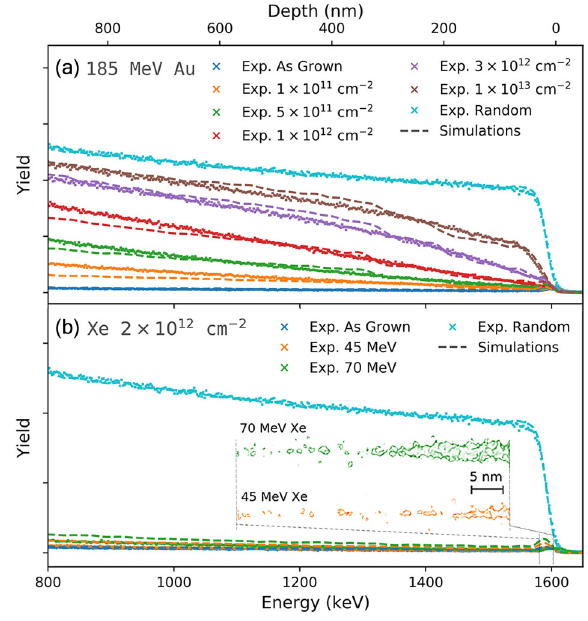
Fig. 6 Rutherford backscattering spectrometry/channelling data of irradiated samples. Aligned and random RBS/C spectra of the samples (symbols) and corresponding simulations (lines) for a 185 MeV Au, b 70 and 45 MeV Xe irradiations. The aligned spectra are obtained by aligning the probe beam along the [001] axis of the samples. The random spectra are collected from the as-grown sample by tilting it by 5 o with respect to the probe beam direction and rotating the sample during the measurement. The inset shows the dislocation extraction algorithm output from the surface simulations for the Xe